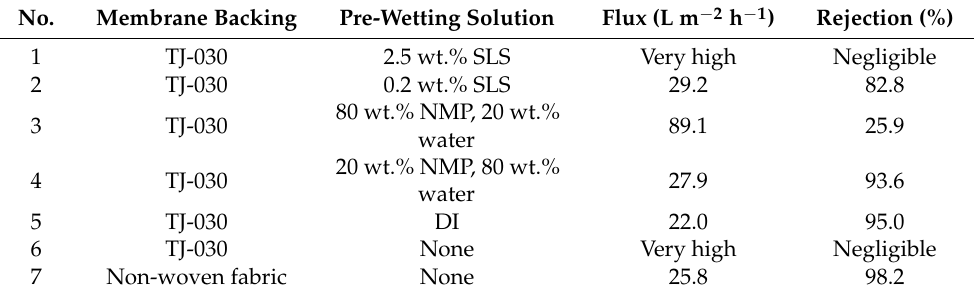
Table 2. Effect of pre-wetting on the RO flux and salt rejection of membrane, using different wetting agents. The RO testing was performed using 2000 mg/L NaCl solution at 15 bar pressure.